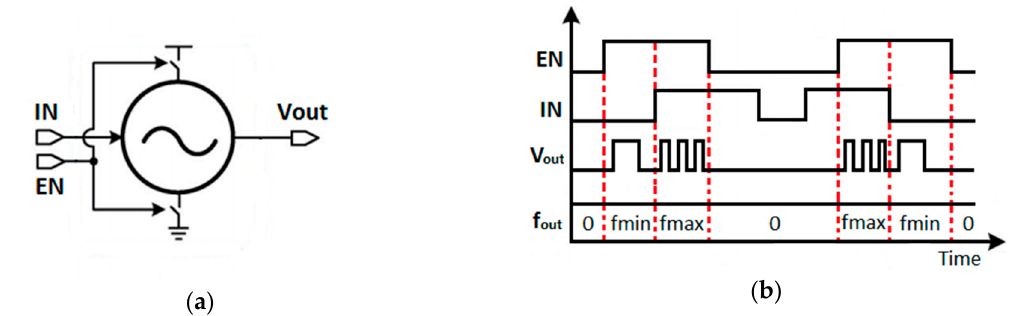
Figure 1. Gated switched-ring oscillator (GSRO): ( a ) block diagram; ( b ) waveforms [20].